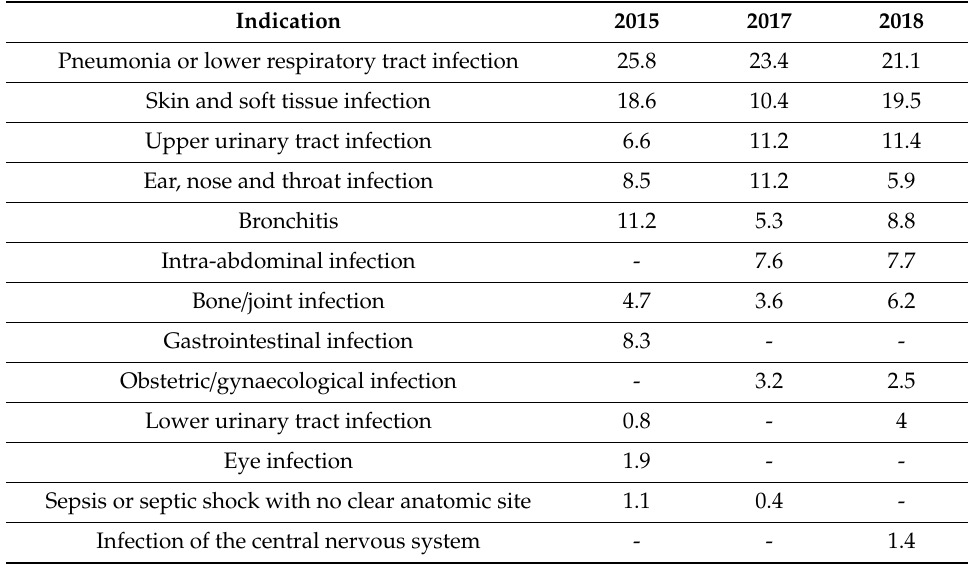
Table 3. The 10 most common diagnoses treated with therapeutic antimicrobials (%).